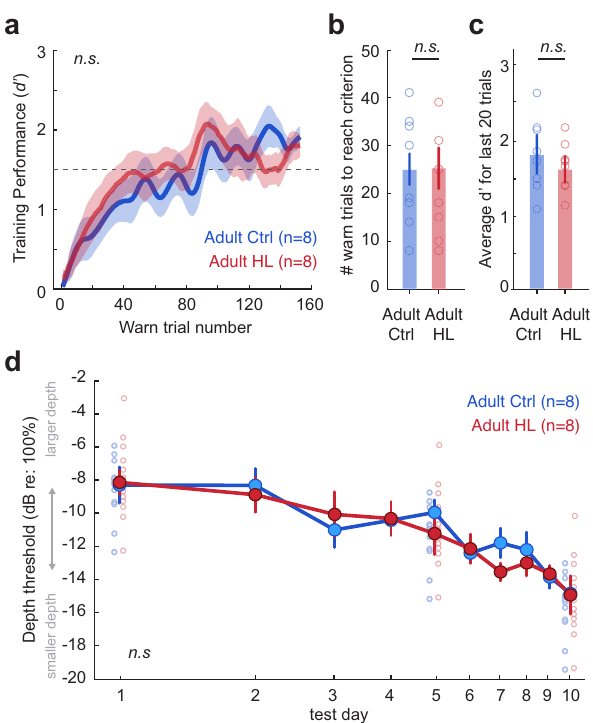
Fig. 4 Adult-onset hearing loss (>P102) of the same duration (80 days) does not impair procedural training or amplitude modulation (AM) depth detection following earplug removal and recovery. a Procedural training sessions (3 – 4 separate sessions) were combined and behavioral performance ( d ′ ) was computed as a function of warn trial number using a 5-trial sliding window. Data for Adult controls (blue; n = 8) and Adult-onset HL (red; n = 8) are depicted as the mean±SEM. b Number of warn trials to reach performance criterion ( d ′ ≥ 1.5). c Average d ′ for the last 20 trials of procedural training prior to psychometric testing. d Psychometric functions were collected for 10 consecutive testing days for Adult controls and Adult-onset HL